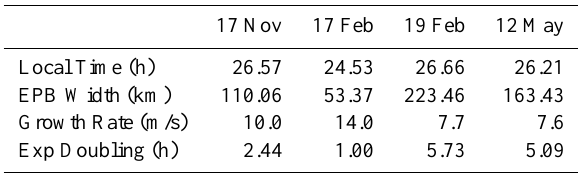
Table 3. Width increase of